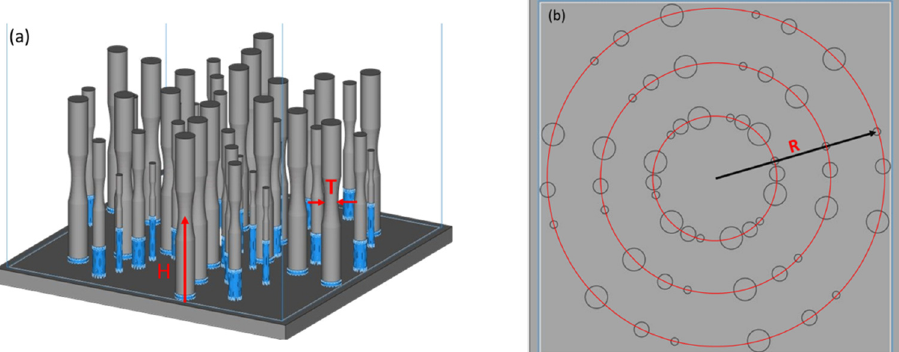
Figure 1. Build design for the preliminary investigation. ( a ) Oblique view of the build design for the as-built fatigue study. Only one height (H) level was printed for this preliminary investigation. Thickness (T) of the parts is the diameter of the thinnest part of the gauge section. ( b ) Top view of the build with red rings indicating the three levels of radial distance (R).